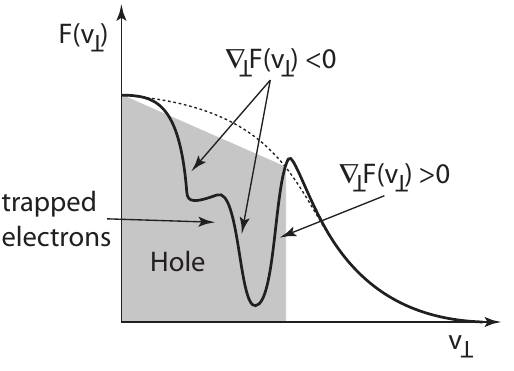
Fig. 5. A model electron distribution in the hole. The hole cuts out part of the distribution but also traps electrons. This causes a pos- itive velocity space gradient at the high velocity space boundary of the hole and a negative gradient at the trapped electron distribution. Radiation is generated at the high electron velocity gradient and ab- sorbed at the low velocity gradient though at different